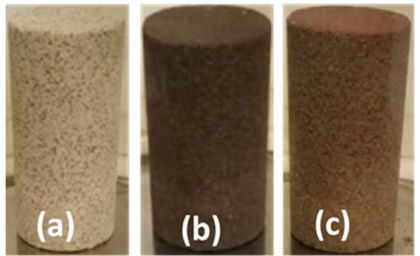
Figure 1. Berea sandstone samples ( a ) dry sample, ( b ) sample saturated with crude oil and ( c ) sample saturated with crude oil and magnetite